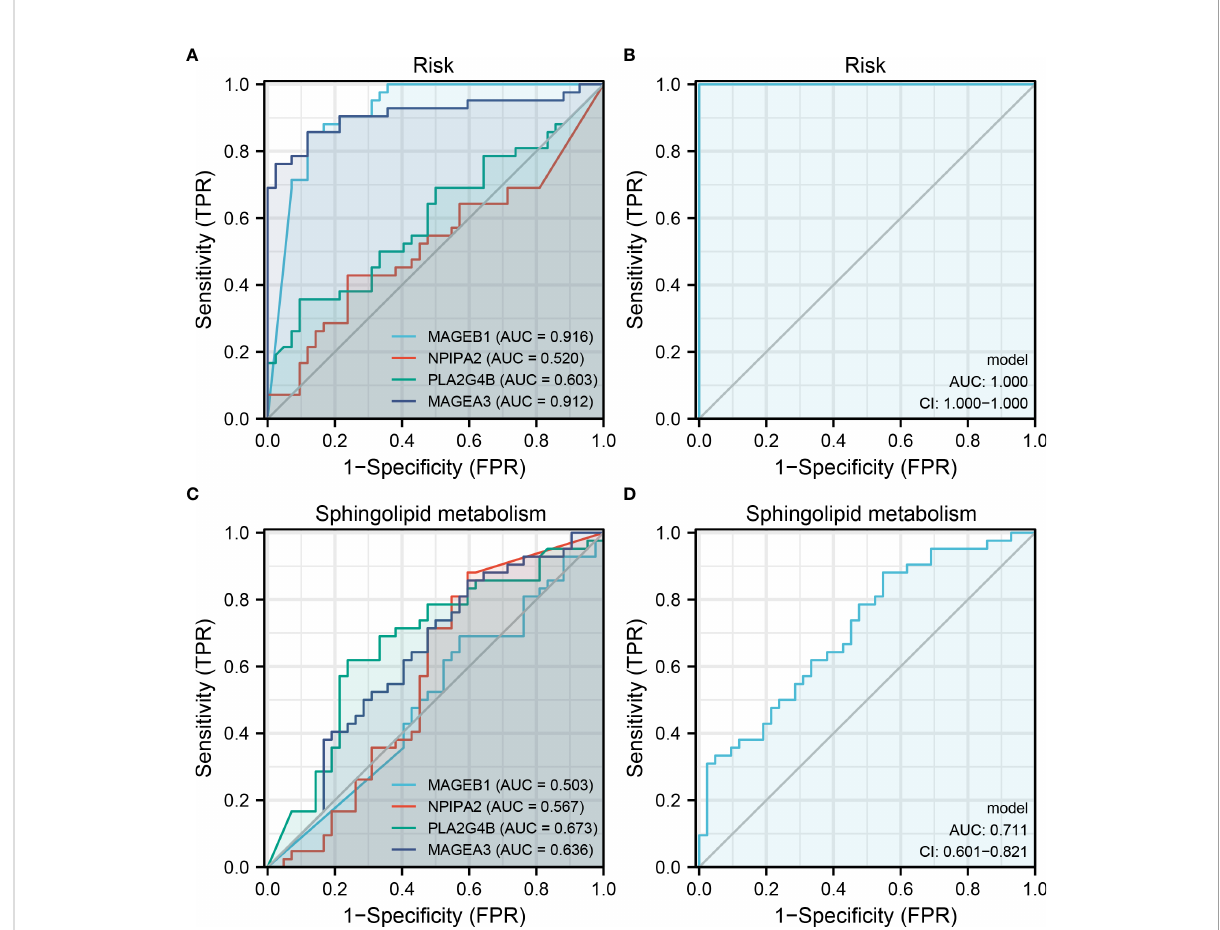
FIGURE 7 MAGEB1, NPIPA2, PLA2G4B and MAGEA3 could indicate sphingolipid metabolism and risk group Notes: (A) ROC curve of MAGEB1, NPIPA2, PLA2G4B and MAGEA3 on risk group prediction; (B) The logistic regression model of these four genes on risk group prediction (17.8664 + -155.4921*MAGEB1 + 894.5988*NPIPA2 + 1238.153*PLA2G4B + -87.4001*MAGEA3); (C) ROC curve of MAGEB1, NPIPA2, PLA2G4B and MAGEA3 on sphingolipid metabolism group prediction; (D) The logistic regression model of these four genes on sphingolipid metabolism group prediction (1.2038 + 0.2264*MAGEB1 + 0.4005*NPIPA2 + -3.024*PLA2G4B +